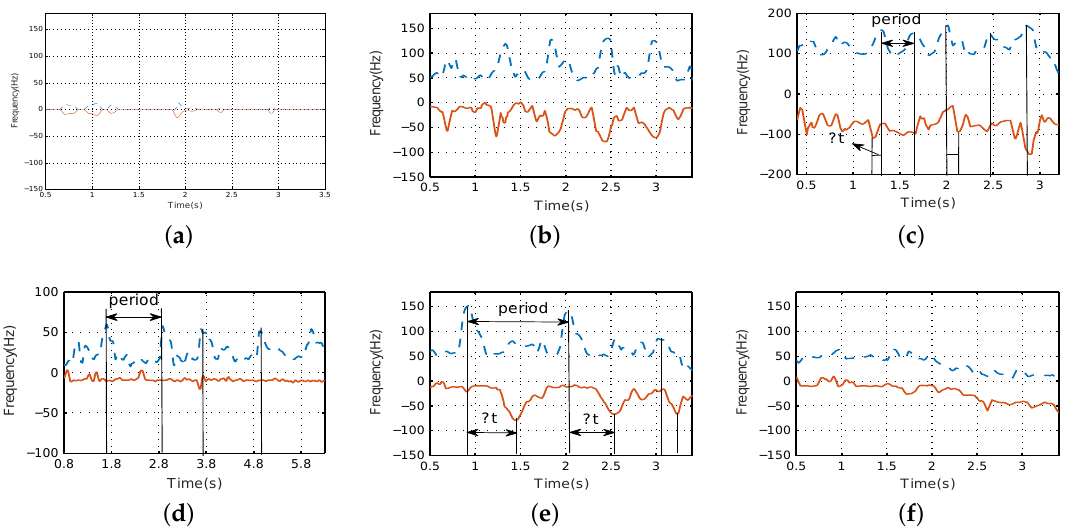
Figure 10. The arm swing envelope analysis of six motion states. ( a ) sitting still; ( b ) walking with both arms; ( c ) running; ( d ) crawling; ( e ) walking with a single arm; ( f ) walking without